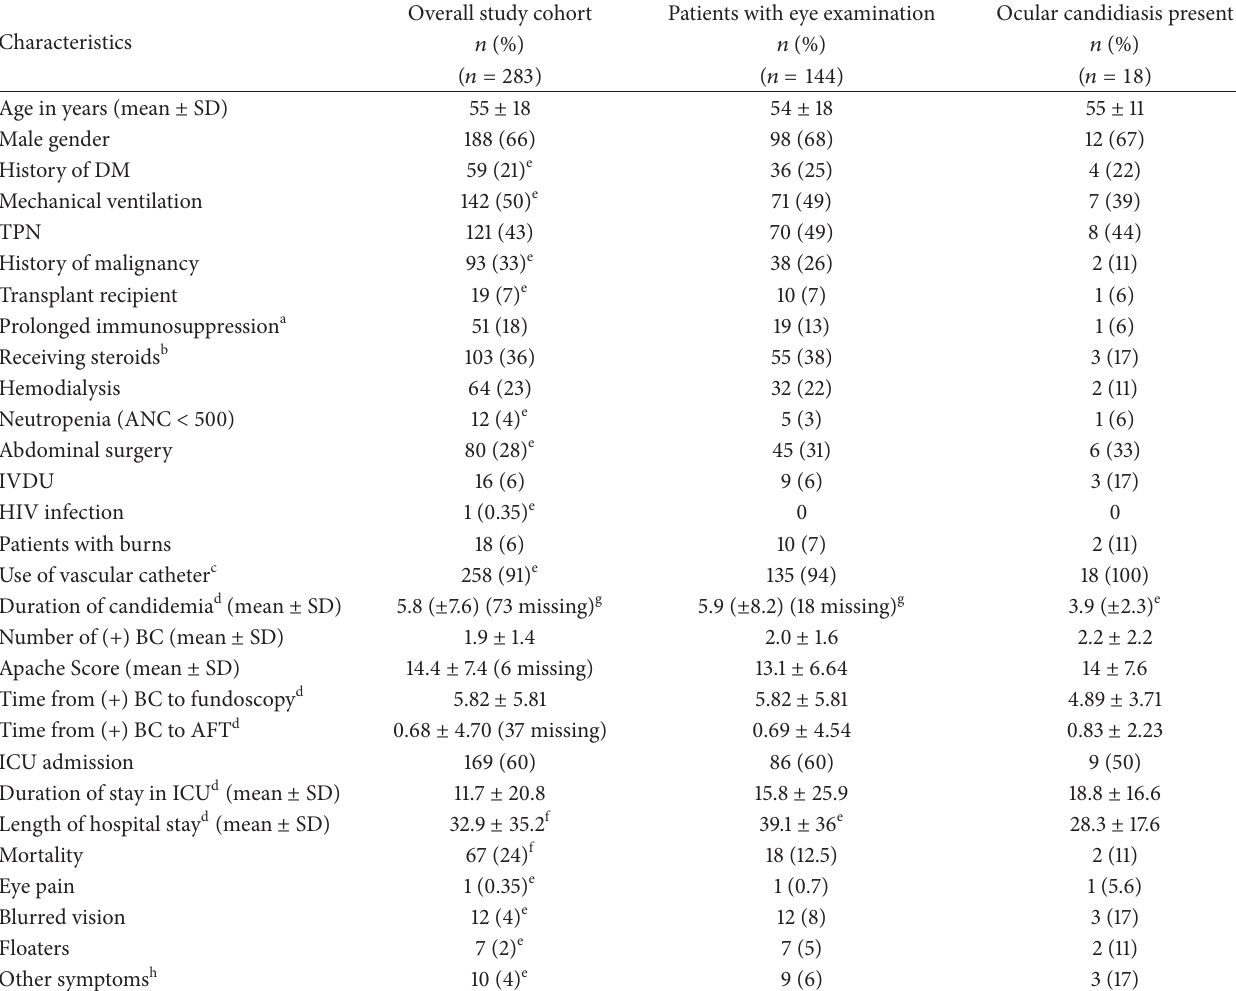
Table 1: Patients